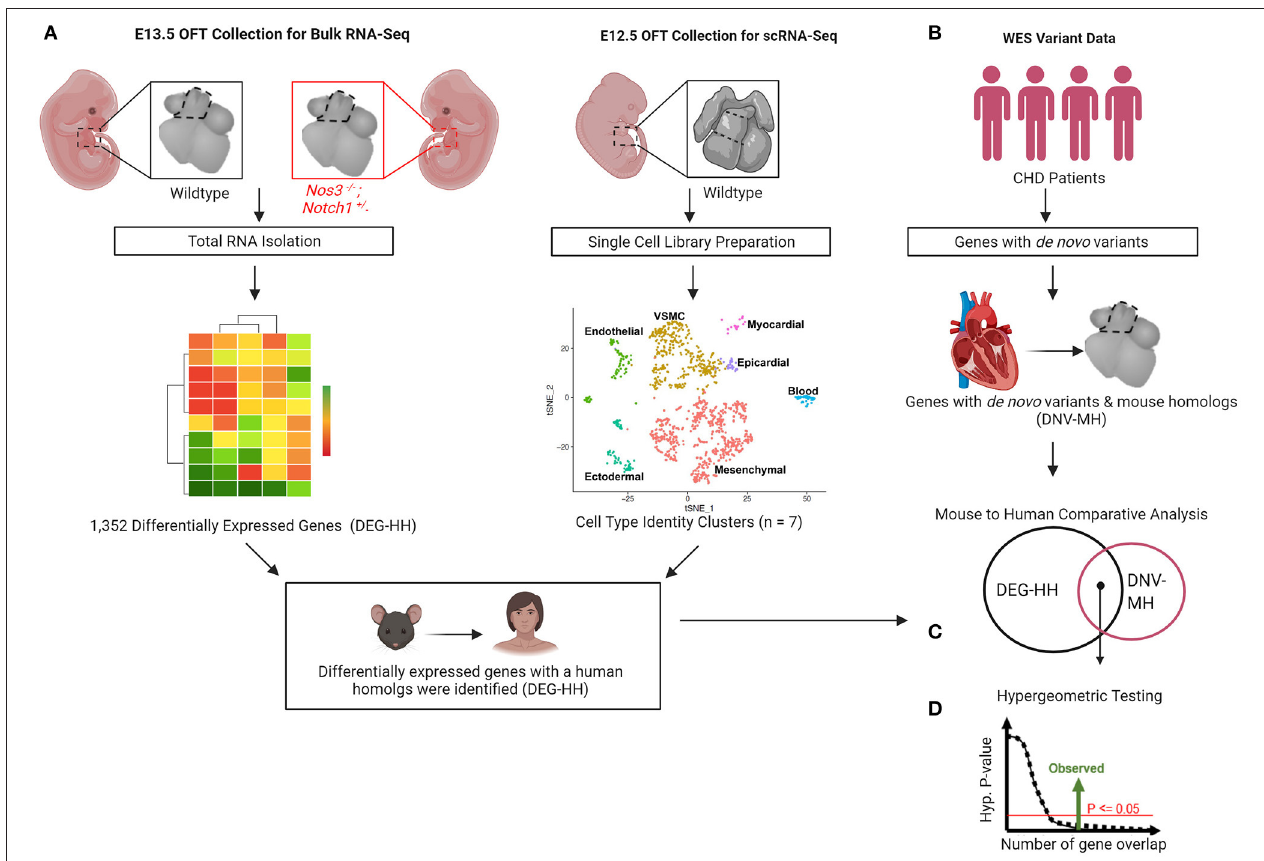
FIGURE 1 | Gene discovery pipeline for human congenital heart disease (CHD) utilizing transcriptomic profiling from wildtype and mutant mouse embryos. (A) Differential gene expression by bulk RNA-Sequencing of E13.5 Notch1 + / − ; Nos3 − / − mutant and wildtype outflow tracts (OFT) was performed. (B) scRNA-Sequencing transcriptomes derived from wildtype OFT was used to categorize cell identity clusters. (C) Differentially expressed genes (DEG) were categorized according to cell identity clusters and human homologs were identified. (D) De novo gene variants were extracted from WES databases of CHD patients and those with mouse homologs identified. (E) Mouse to human comparative analysis with hypergeometric testing was performed to determine statistical